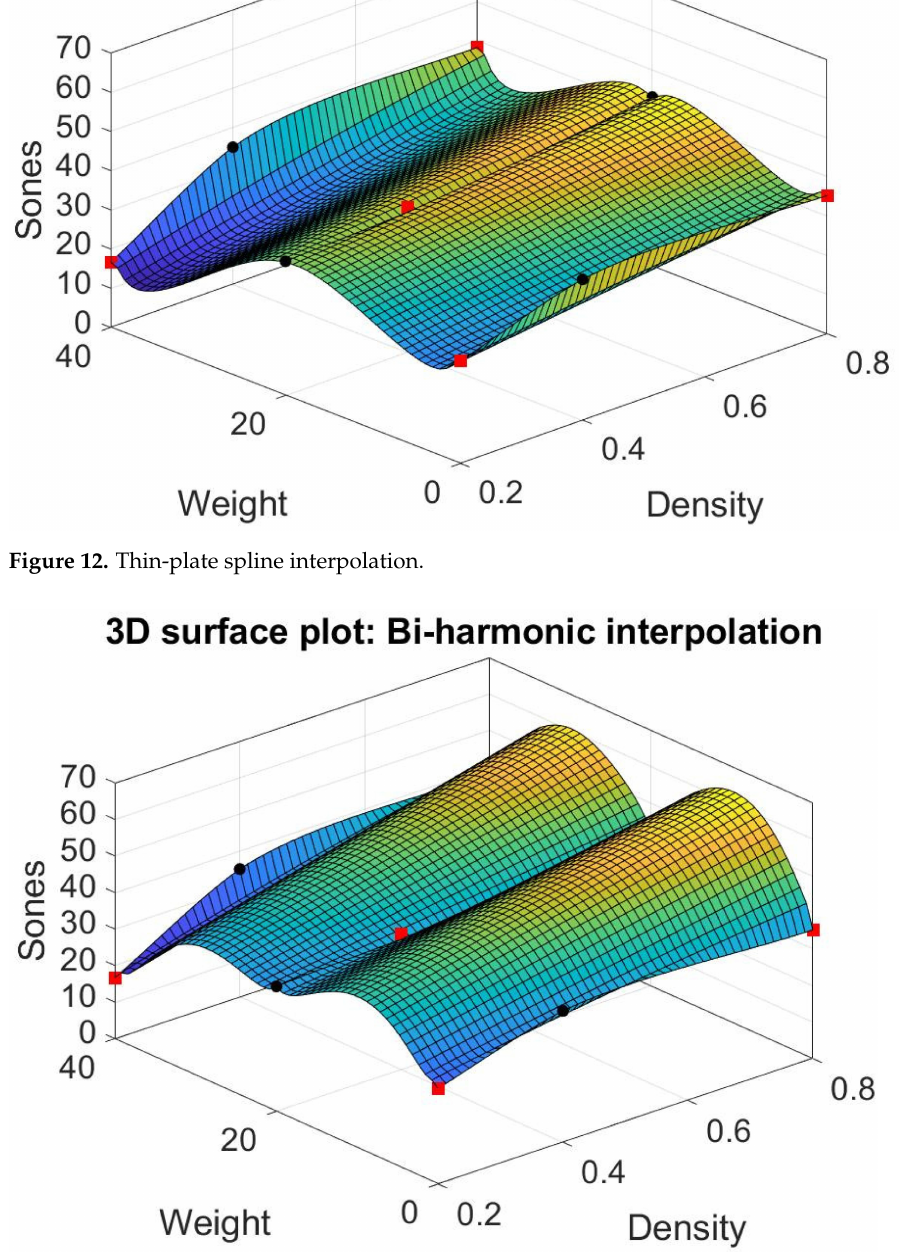
Figure 13. Bi-harmonic